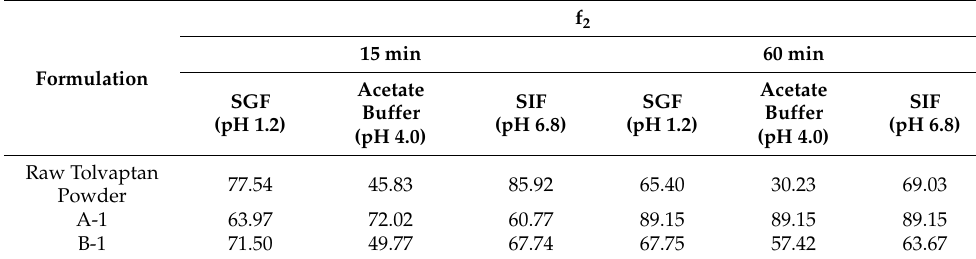
Figure 6. Dissolution profile of raw tolvaptan powder and formulations A ‐ 1 and B ‐ 1 in various media: ( a ) distilled water, ( b ) SGF (pH 1.2), ( c ) acetate buffer (pH 4.0), and ( d ) SIF (pH 6.8). ■ raw tolvaptan powder, □ raw tolvaptan powder plus 0.22% SLS, ● formulation A ‐ 1. ○ formulation A ‐ 1 plus 0.22% SLS, ▲ formulation B ‐ 1, △ formulation B ‐ 1 plus 0.22% SLS. Table 5. The similarity factor (f 2 ) of dissolution curves of raw tolvaptan powder and optimized formulations A-1 and B-1 between distilled water and SGF (pH 1.2), acetate buffer (pH 4.0), and SIF (pH 6.8) at 15 min and 60